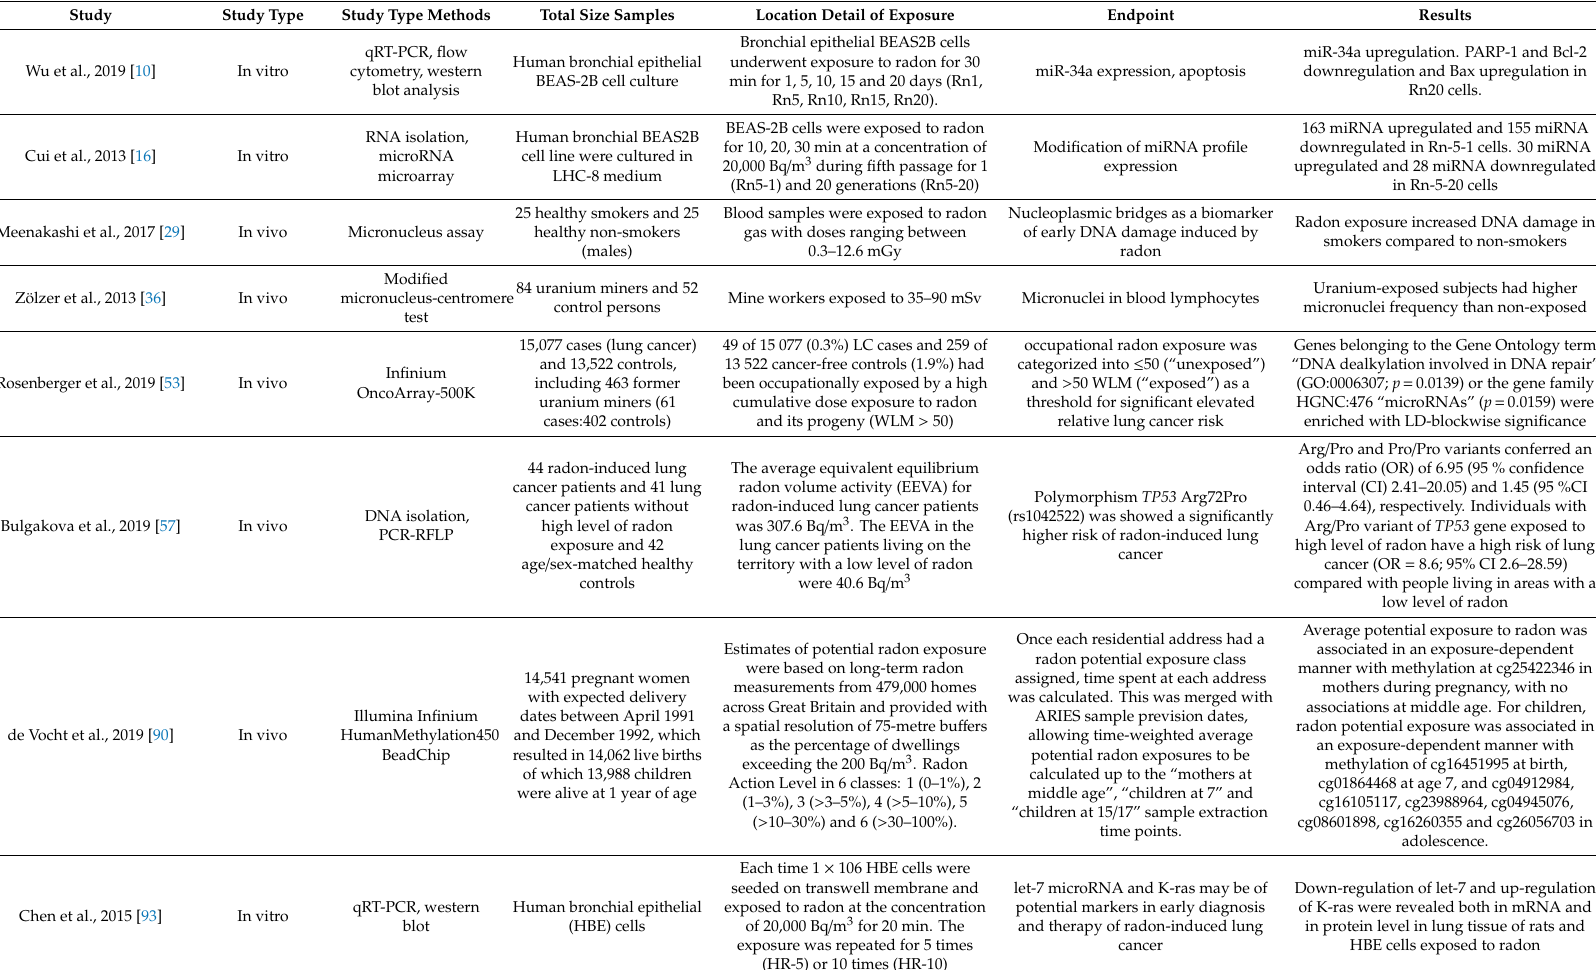
Table 1. Main cytogenetic and “omics” biomonitoring studies focused on the e ff ect of radon on various biomarkers including